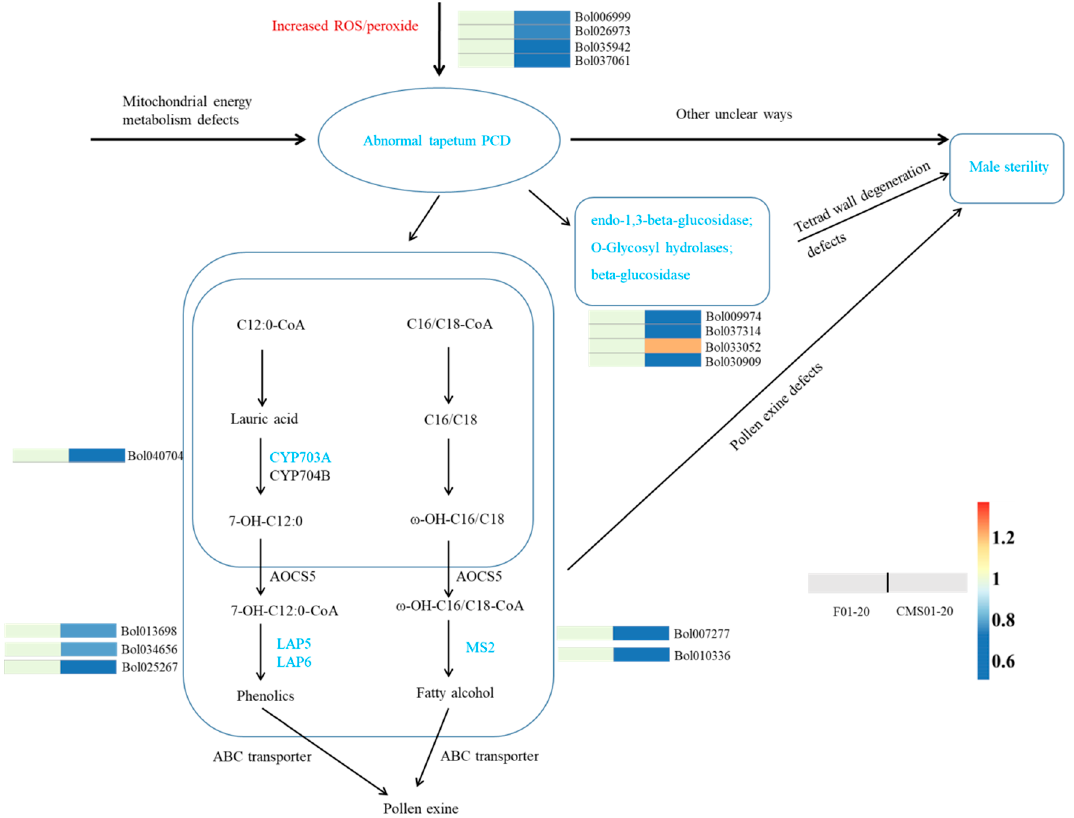
Figure 5. A possible network according to which abnormal tapetal programmed cell death is triggered by reactive oxygen species (ROS), resulting in male sterility. The differential abundance protein species involved in pollen exine formation and tetrad wall degeneration are also shown. The fold changes of differential abundance protein species are indicated by the colour filled in the squares.